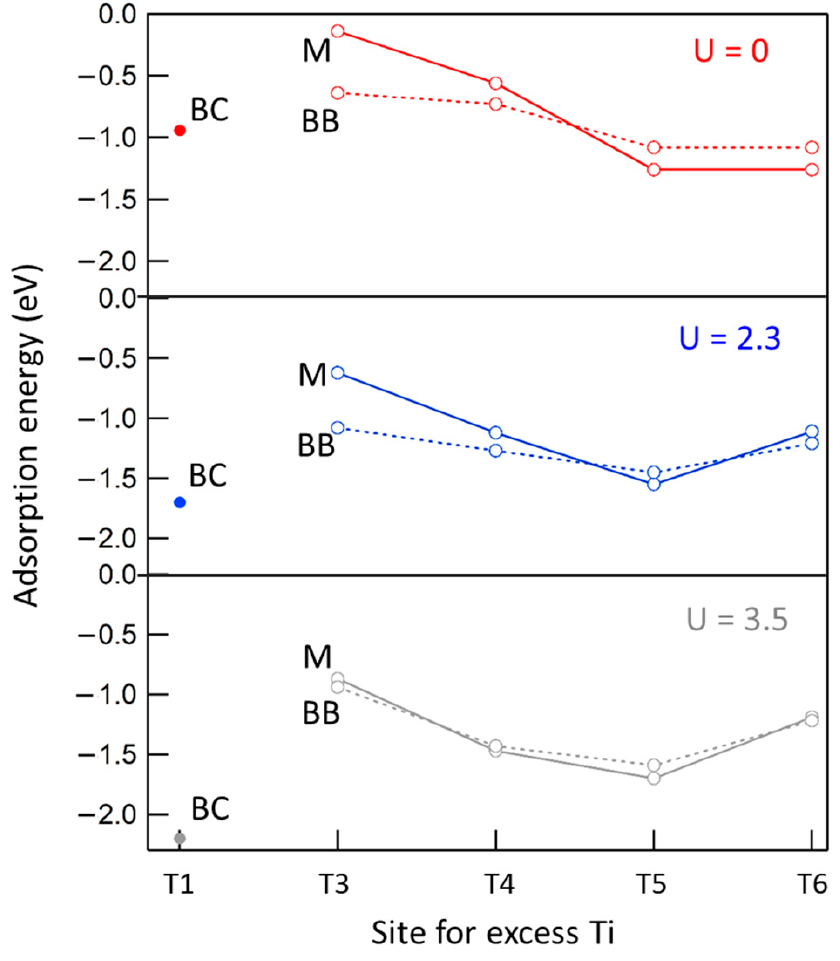
Figure 6. Adsorption energy at the a-TiO 2 (101) surface for formic acid in the monodentate form (M, solid line) and in the bidentate form (BB, dotted line) as a function of the site for the excess Ti atom. BC indicates a bidentate chelating species where the excess Ti is an adatom.